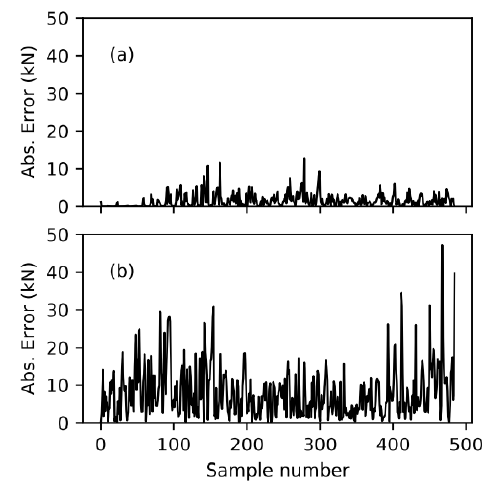
Figure 7. Time histories absolute error of ( a ) ELM − SVM model and ( b ) GPNN model [22] for concrete beam − column connection .